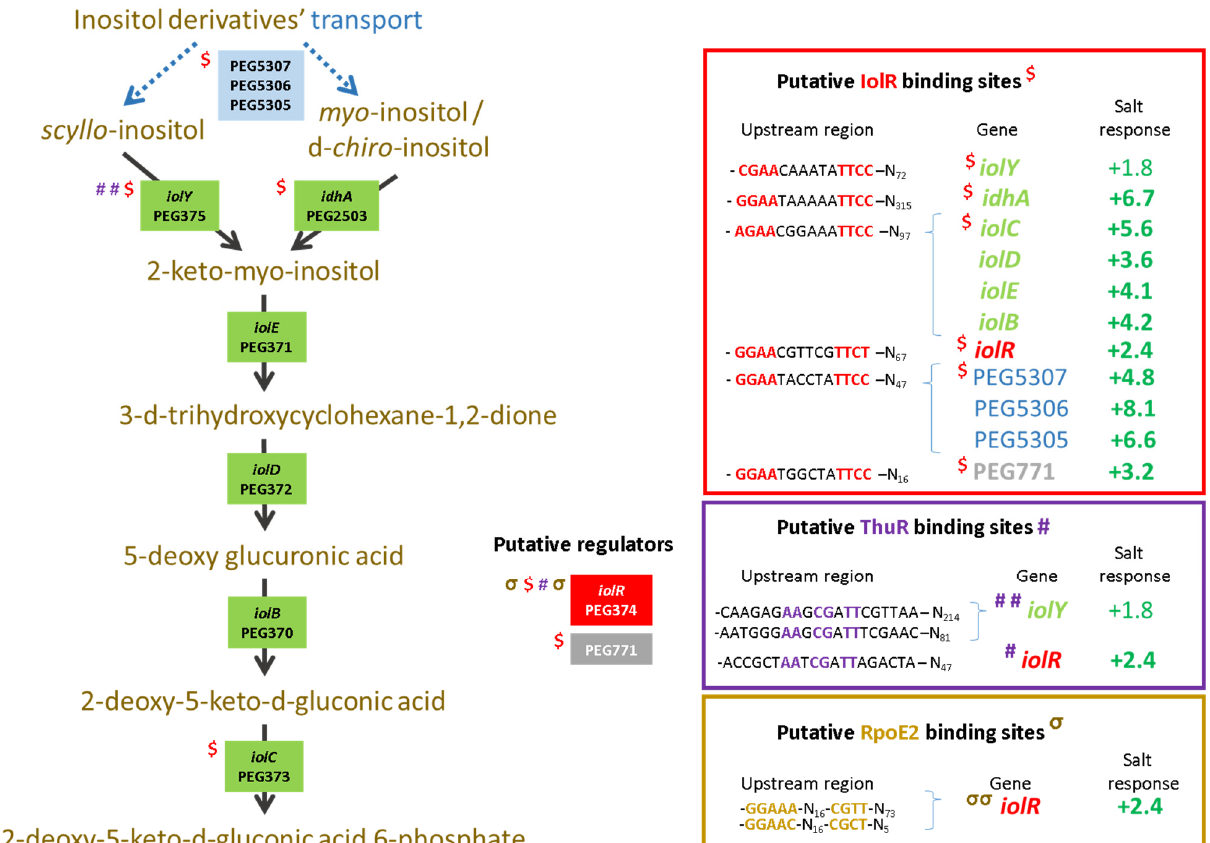
Figure 8. Catabolism of inositol. Ensifer aridi -predicted encoding genes (PEGs) involved in the transport and catabolism of inositol are shown in the metabolic pathway. The presence of putative IolR, ThuR, and RpoE2 binding sites upstream of genes (shown on the right boxes) are indicated, respectively, by “$”, “#”, and “ σ ” on the left of genes when identified and the position of conserved residues are bolded and colored accordingly in boxes. The salt response refers to fold change previously found by RNAseq [15]. Positive fold changes indicating upregulation (green) in salt containing medium are bolded when ≥